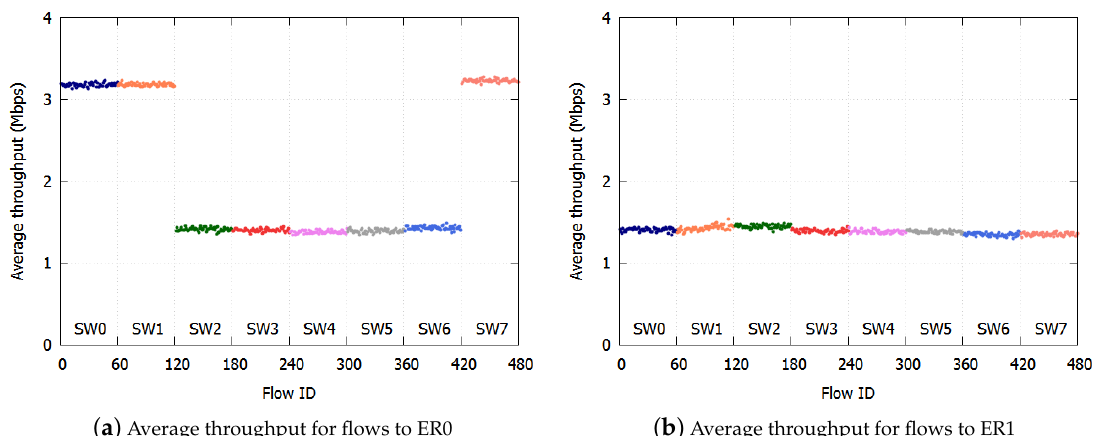
Figure 6. Simulation results with existing NRN + 1CM. The throughput unfairness occurred especially with flows destined for